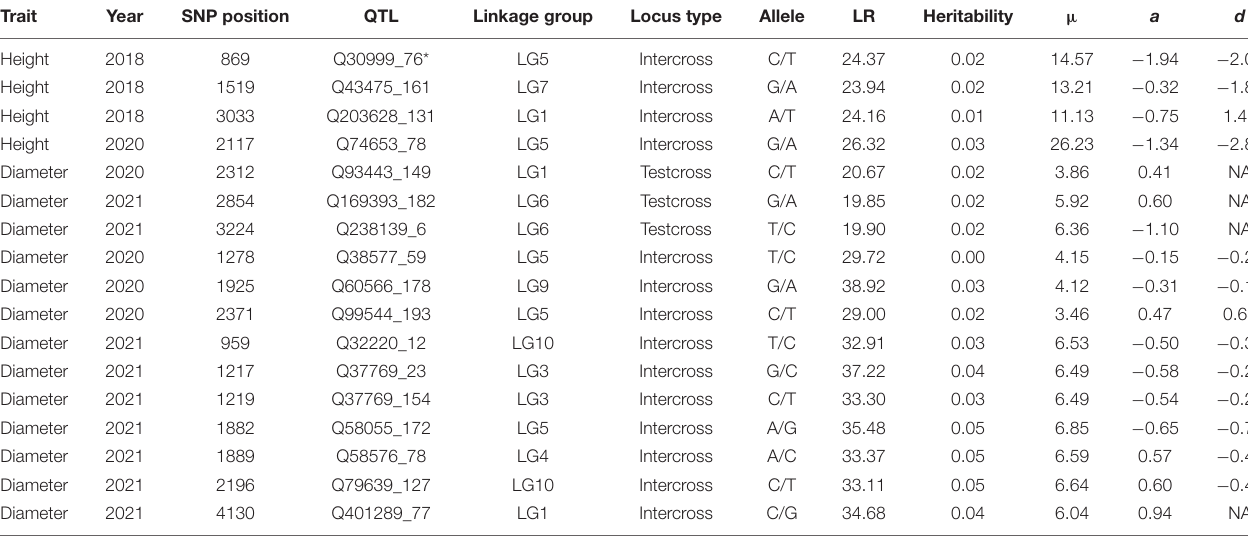
TABLE 4 | Seedling growth-associated QTLs identified and their genetic effects on growth of different years in T. grandis.